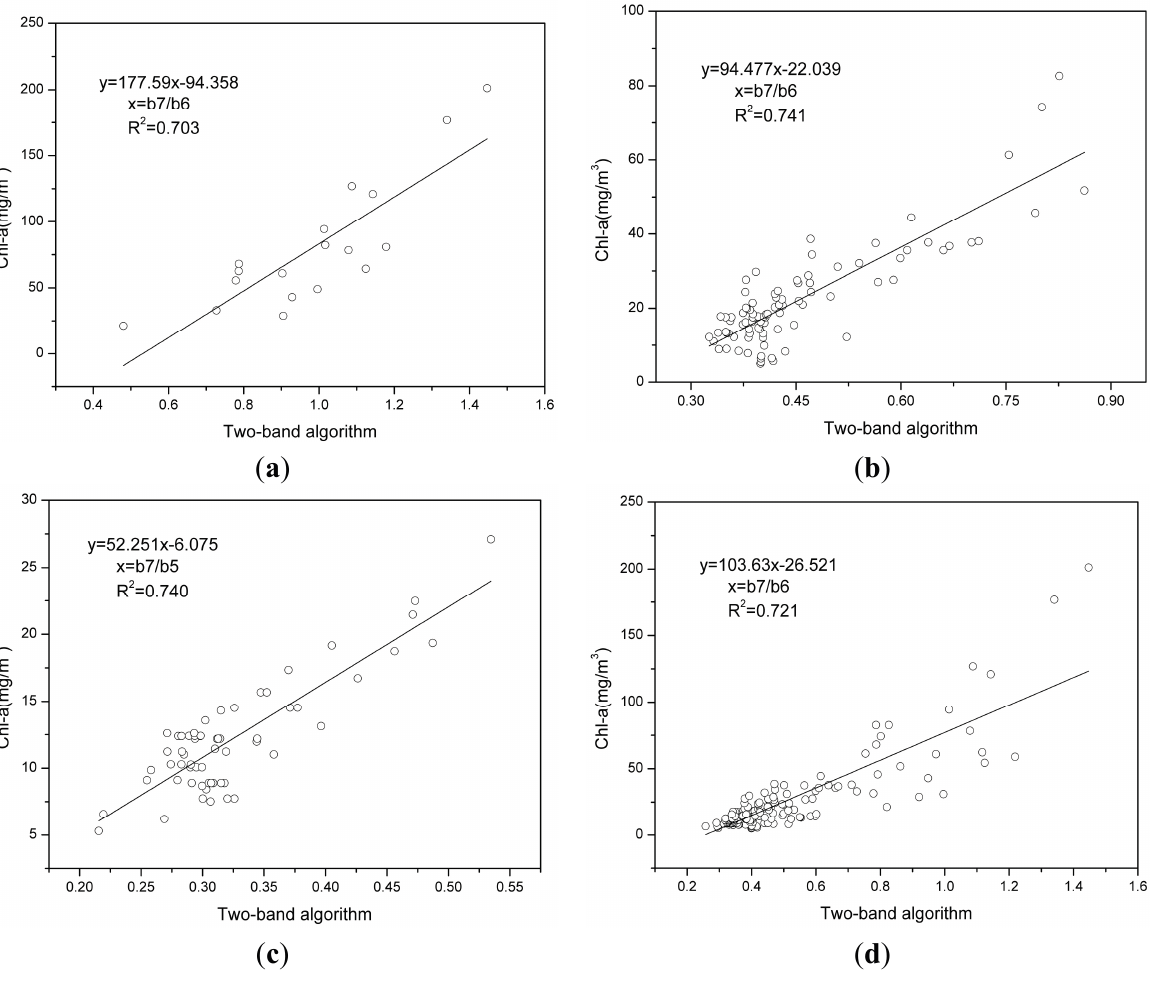
Figure 3. Scatterplot of the Chl-a estimation by the two-band model and the measured Chl- a for GOCI data: ( a ) Class 1; ( b ) Class 2; ( c ) Class 3; and ( d ) overall